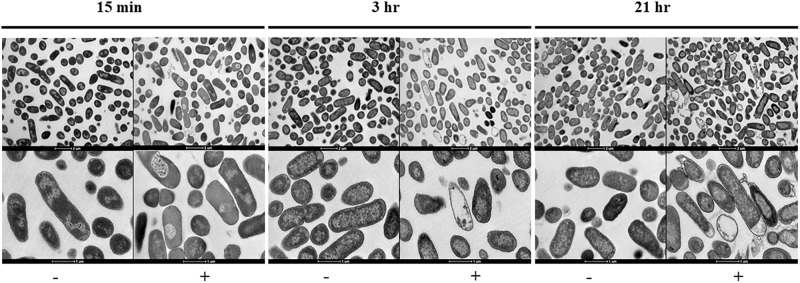
Transmission electron micrographs sowing the morphological changes observed on NMP treated K. pneumoniae MGH 78578. Images were collected after 15 min, 3- and 21-h of exposure to NMP. The images in the top panel were magnified 6,000X, bottom panel images shown were magnified 16,500X. The sign ‘–’ denotes DMSO and ‘+’ denotes DMSO plus NMP.